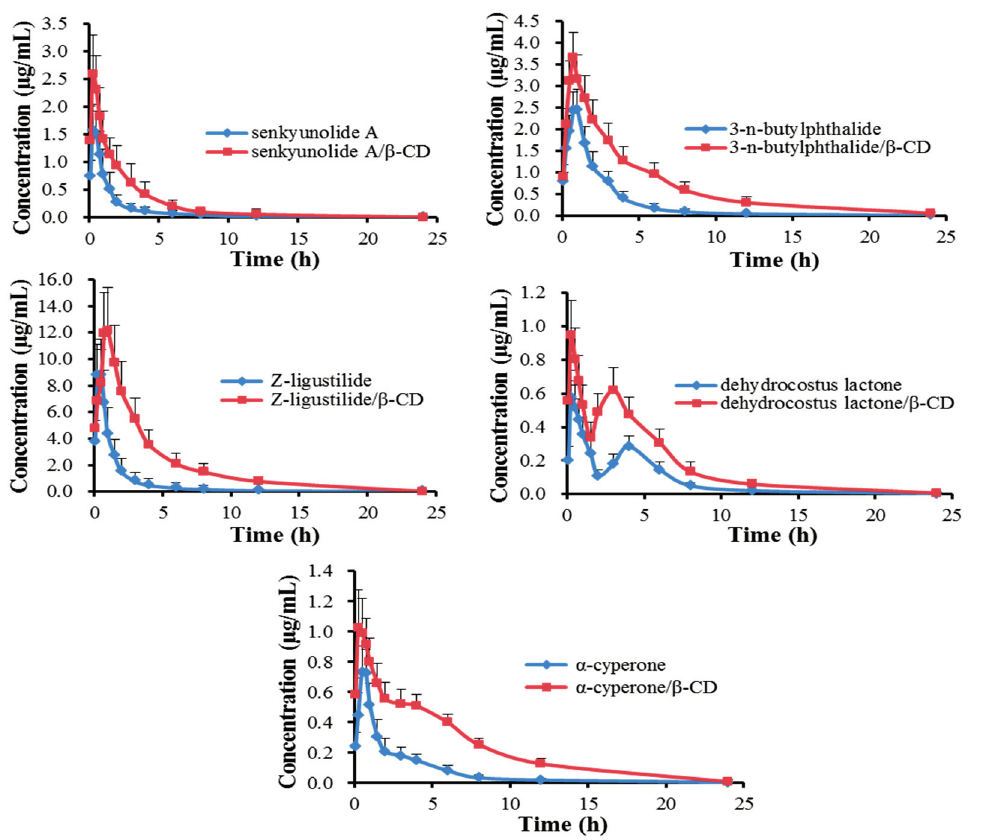
Figure 7. Mean (±S.D.) plasma concentration-time profiles of five active compounds after oral administration of XEO and its β -CD inclusion complex ( n =